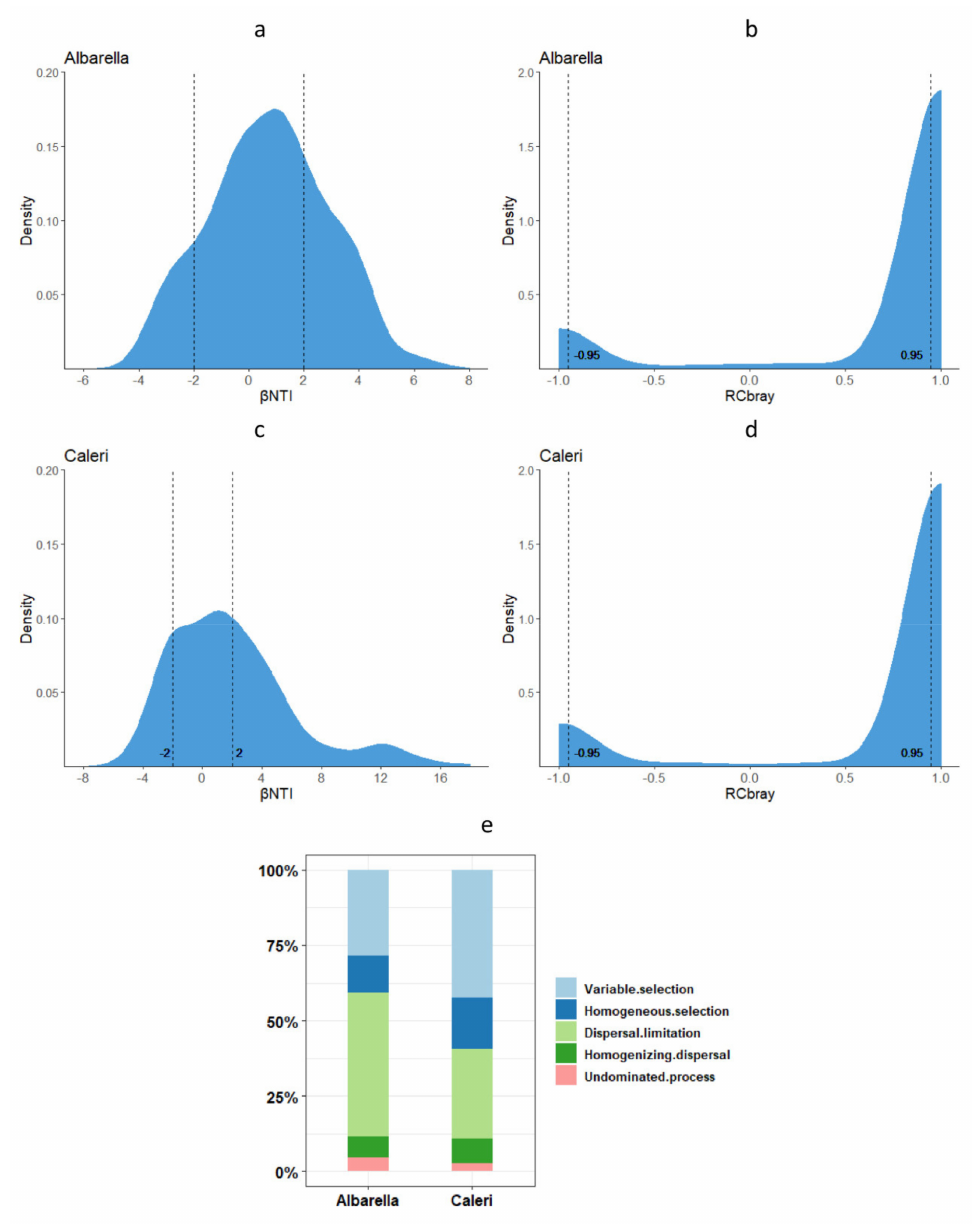
Figure 7. Distribution of standardized phylogenetic turnover and taxonomic turnover of soil bacteria within Albarella and Caleri. ( a ): β NTI of Albarella, ( b ): RCBray of Albarella, ( c ): β NTI of Caleri, ( d ): RCBray of Caleri, ( e ): percentages of the five structuring processes in Albarella and